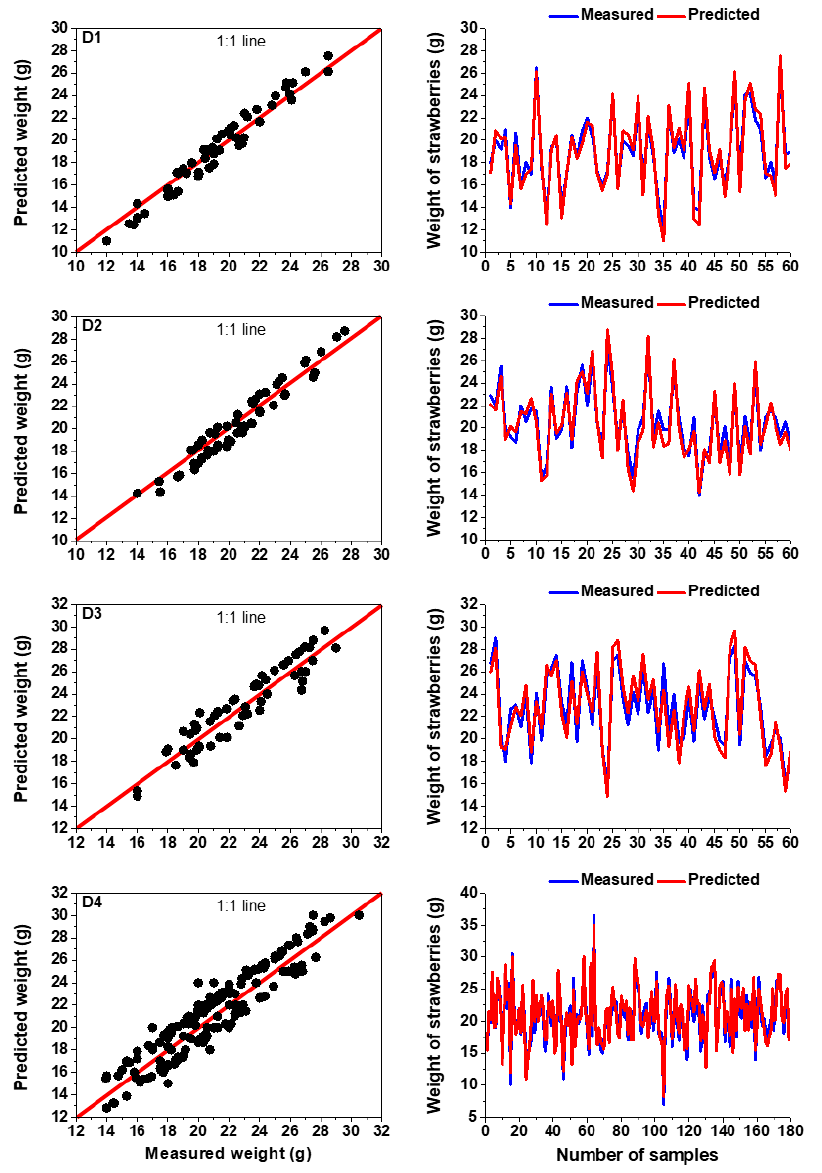
Figure 6. Scatter plots with 1:1 line and time series graph for comparing results between measured and predicted values by LR model with D1, D2, D3, and D4 datasets for fruit weight prediction of strawberries in the testing period. D1: measured vs. predicted data for Maehyang cultivar; D2: measured vs. predicted data for Seolhyang cultivar; D3: measured vs. predicted data for Santa cultivar; D4: measured vs. predicted data for all three cultivars.